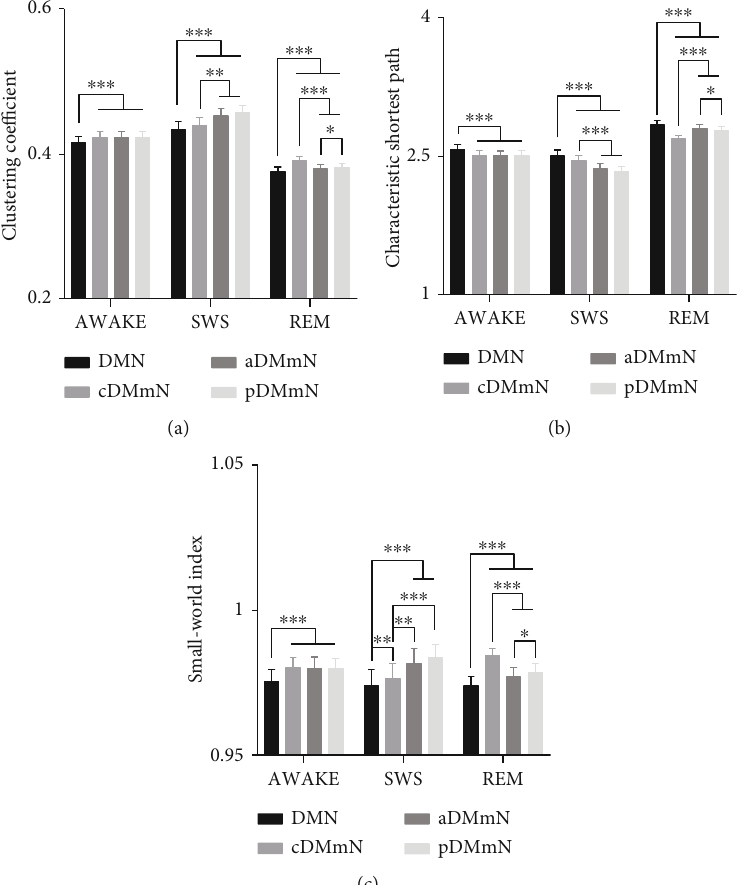
Figure 5: The clustering coe ffi cients, characteristic shortest paths, and small-world indices of the three CAMP networks and the DMN in each state of consciousness. (a) Comparisons of clustering coe ffi cients. (b) Comparisons of characteristic shortest paths. (c) Comparisons of small-world indices. ∗ indicates a signi fi cant di ff erence with p < 0 : 05 . ∗∗ indicates a very signi fi cant di ff erence with p < 0 : 01 . ∗∗∗ indicates the most signi fi cant di ff erence with p < 0 : 001